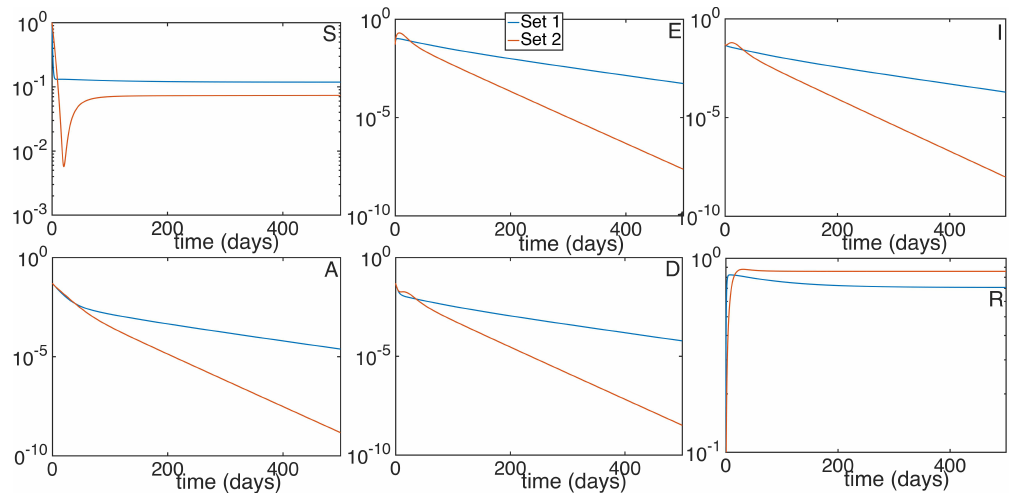
Figure 6. Time evolution of the different subpopulations given a R 0 = 0.81 and two different sets of control vaccination gains. Set 1 shares common parameters with set 2 except for V = 0 and K V = 0.89, while set 2 presents V = 0.13 and K V = 0.